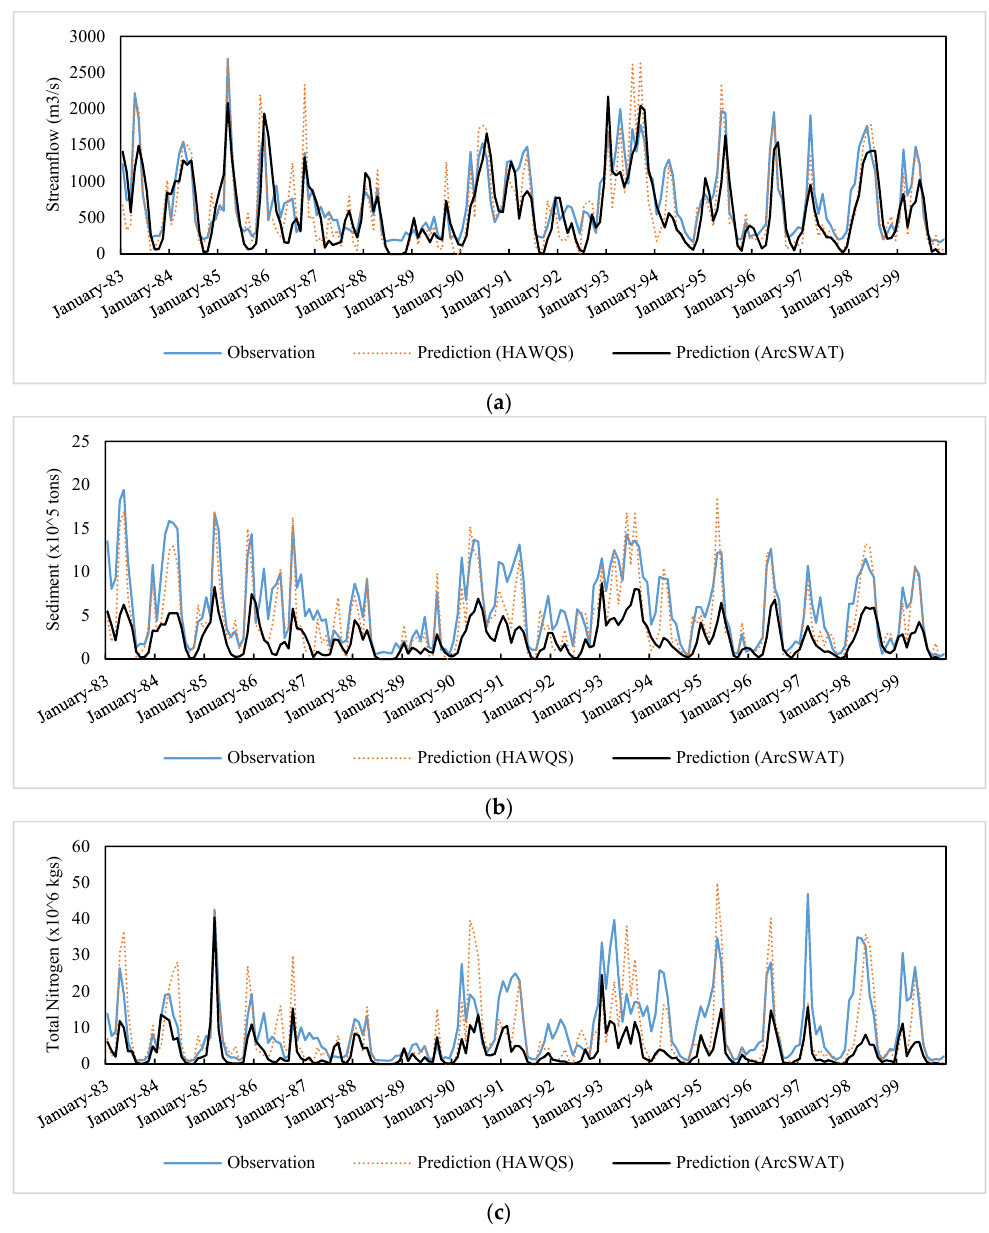
Figure 10. Time series comparisons between observed and predicted flow, sediment and TN for calibration and validation periods for the Illinois River Basin. ( a ) Streamflow; ( b ) Sediment; ( c ) Total Nitrogen. Table 3. General comparisons between HAWQS and ArcSWAT.